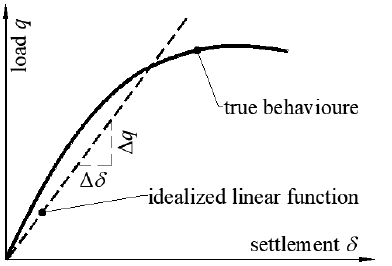
Figure 2. Load–deformation response of the supporting medium.